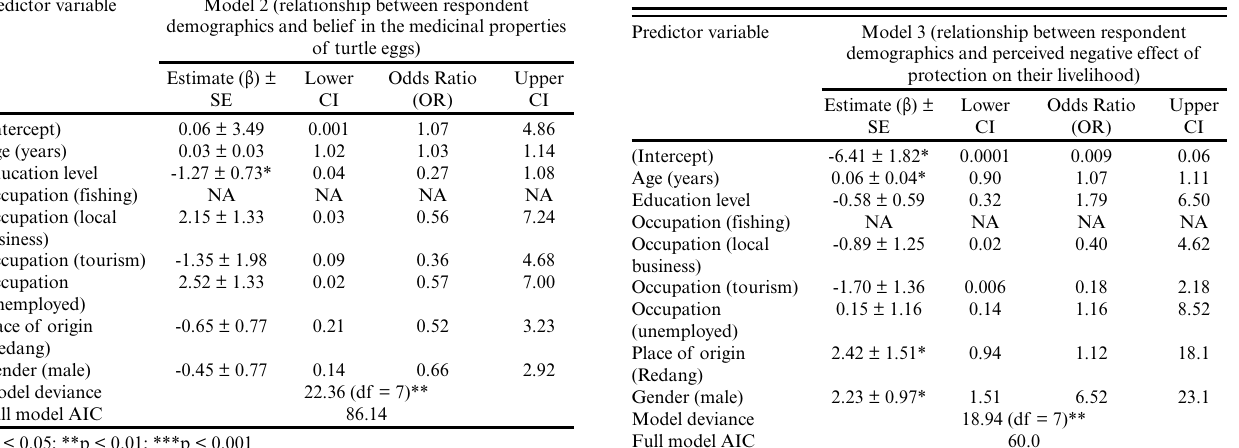
Table 5 . Results of the logistic regression model that explains the influence of respondents’ age on the belief in medicinal properties of turtle eggs (n = 73). Values indicate the coefficient estimates ( β ) ± standard errors of estimates (SE), model deviance and the associated degrees of freedom (df), and p-value.